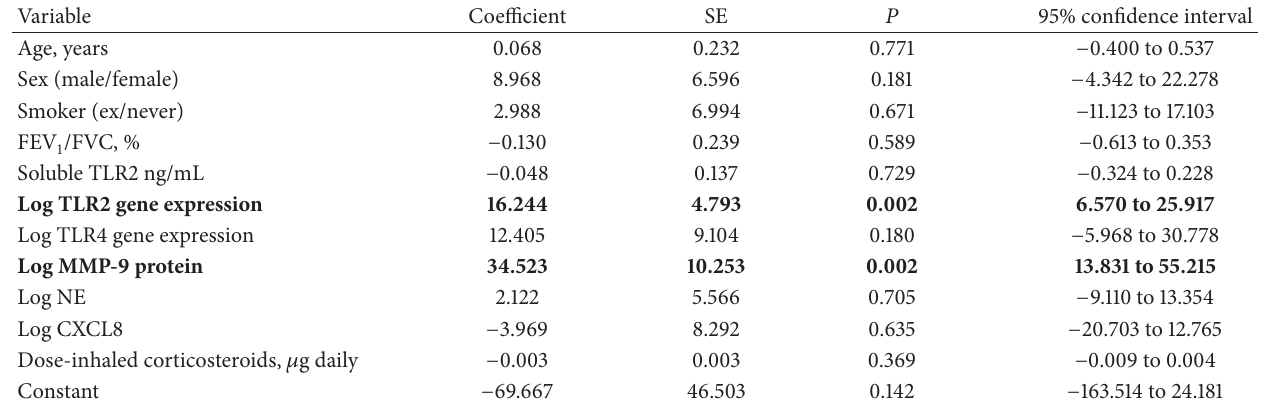
Table 4: Multivariate linear regression outcomes to determine predictors of sputum neutrophil proportion.